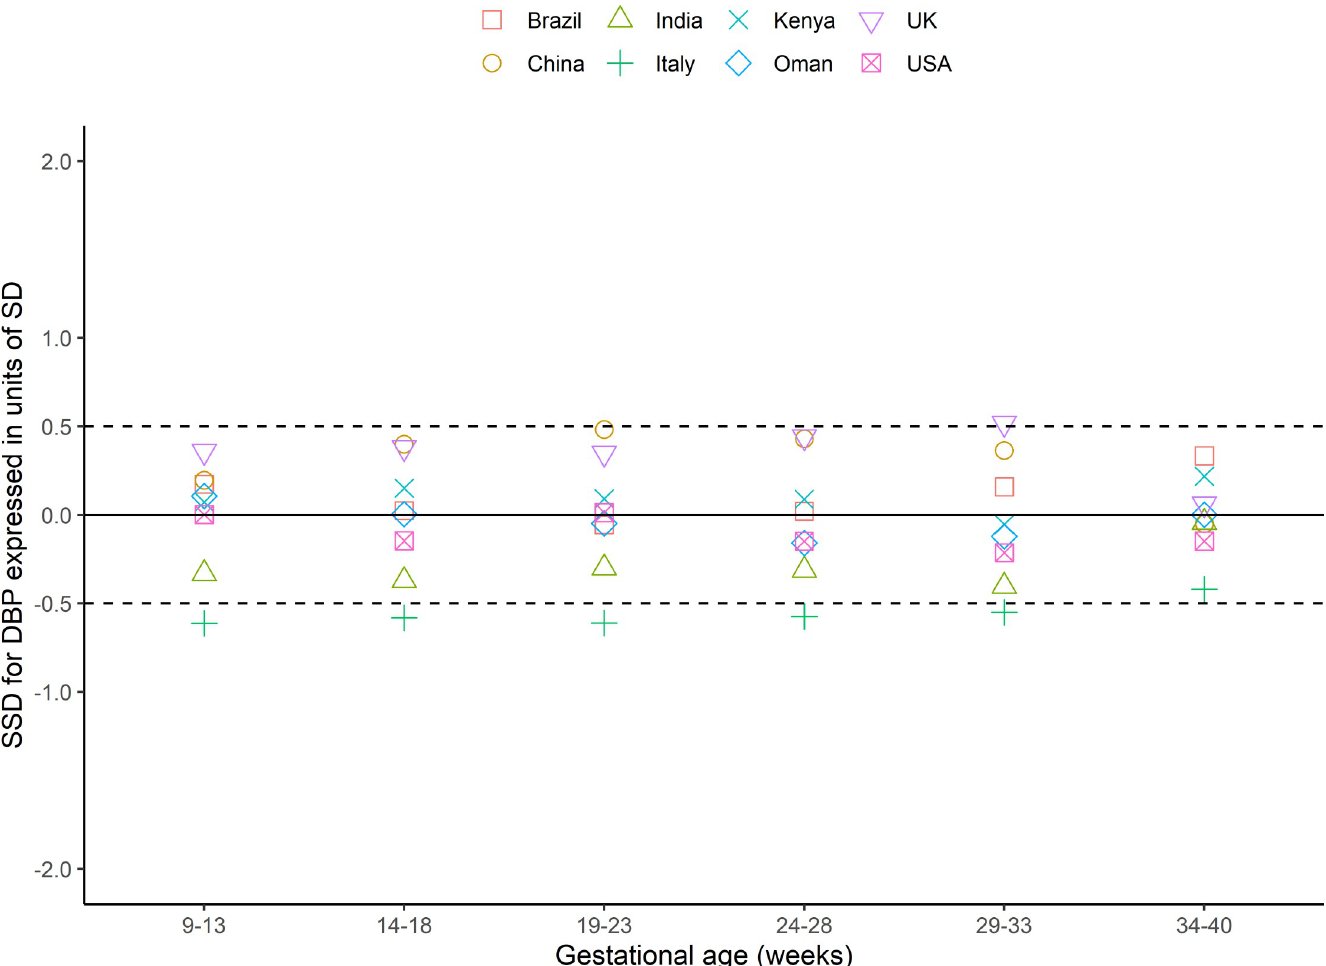
Fig 3. SSD for diastolic blood pressure in the FGLS of the INTERGROWTH-21st Project. DBP, diastolic blood pressure; FGLS, Fetal Growth Longitudinal Study; SD, standard deviation; SSD, standardised site difference. Fig 4 represents the smoothed, pregnancy-specific, third, 10th, 50th, 90th, and 97th centiles for systolic and diastolic blood pressure. Gestational age-specific values for the smoothed cen- tiles and a plot of the smoothed centiles with associated 95% CI can be found in Table C and Fig B in S3 Text.